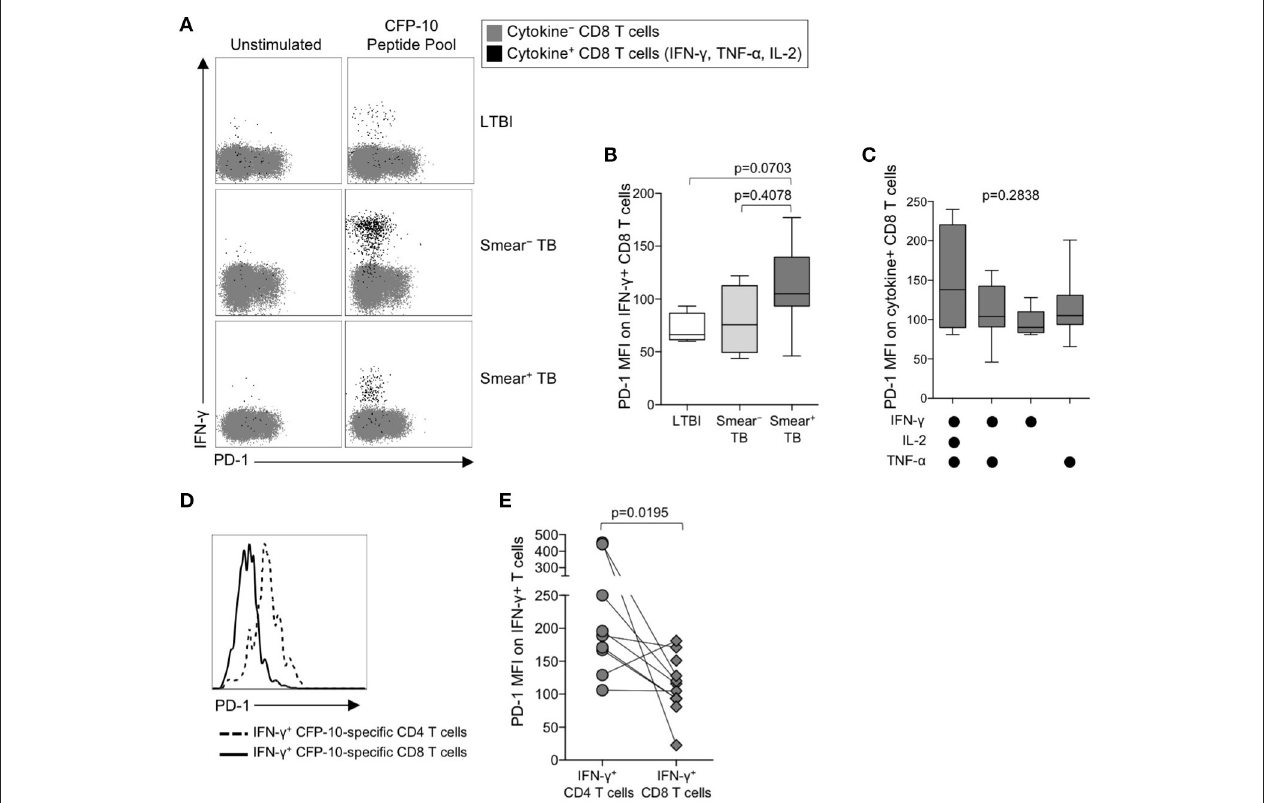
FIGURE 3 | PD-1 is expressed at lower levels by CFP-10/ESAT-6-specific CD8T cells, compared with CD4T cells specific for the same antigens. PD-1 expression on CFP-10 and ESAT-6-specific CD8T cells was performed as described in Figure 2 . (A) Representative flow cytometry data indicating PD-1 expression by CFP-10-specific CD8T cells producing IFN- γ , TNF- α , and/or IL-2. Flow plots are shown gated on viable CD3 + CD8 + lymphocytes; gray cells indicate cytokine − CD8T cells and black cells indicate cytokine-positive CD8T cells expressing any combination of IFN- γ , TNF- α , and IL-2. (B) PD-1 expression by CFP-10/ESAT-6-specific IFN- γ + CD8T cells (LTBI: n = 4; smear − TB: n = 4; smear + TB: n = 13). Differences were assessed by a Kruskal-Wallis test; the p -values shown have been adjusted for multiple comparisons using Dunn’s post-test. (C) PD-1 expression on subsets of CFP-10/ESAT-6-specific CD8T cells from smear + TB patients producing the indicated combinations of IFN- γ , TNF- α , and IL-2. Only cytokine + subsets present at ≥ 0.01% of CD8T cells, after subtraction of background cytokine production, were analyzed for PD-1 expression. No significant differences in PD-1 expression were found between any of the different cytokine-producing subsets (Kruskal-Wallis test). (D) Histogram overlay comparison of PD-1 expression on IFN- γ + CD4 and CD8T cells following stimulation of whole blood from a smear + TB patient with a CFP-10 peptide pool. The dotted line represents PD-1 MFI on IFN- γ + CD4T cells and the solid line represents PD-1 MFI on IFN- γ + CD8T cells measured at the same time in the same individual. (E) Comparison of PD-1 expression on IFN- γ + CD4 and CD8T cells specific for the same antigen (either a CFP-10 peptide pool or an ESAT-6 peptide pool) within the same individual ( n = 9 smear + TB patients). Differences in PD-1 expression between Mtb-specific CD4 and CD8T cell responses within the same individual were determined by the Wilcoxon matched pairs signed rank test. For box plots in (B, C) , the horizontal line represents the median, the box the interquartile range, and the whiskers the 10th and 90th